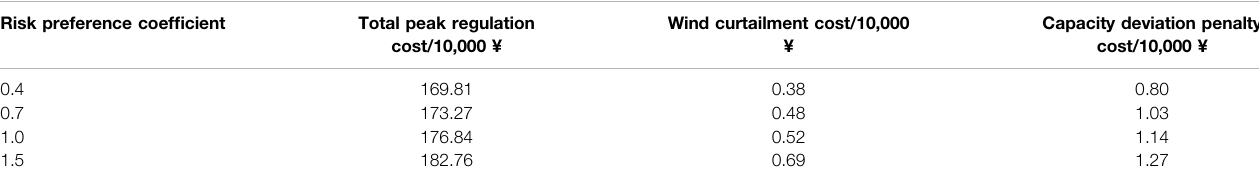
TABLE 4 | Cost analysis table under different risk preference coef fi cients. Risk preference coef fi